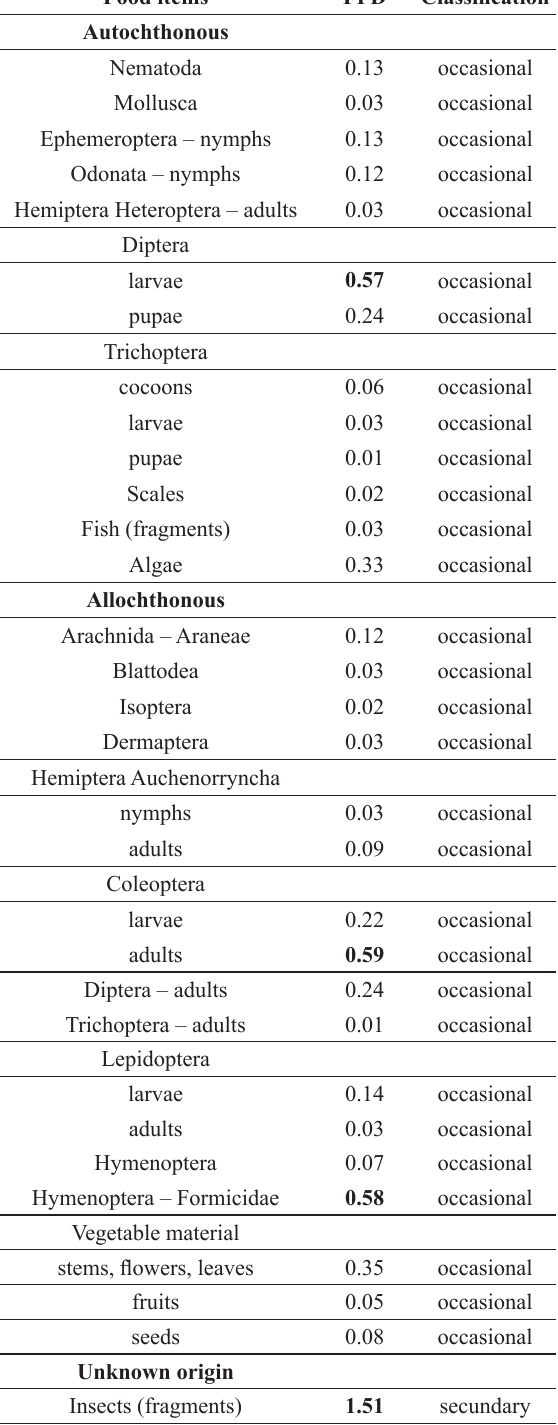
= -0.24, β = 1.07, F = 19.17, p 0 1 1,12